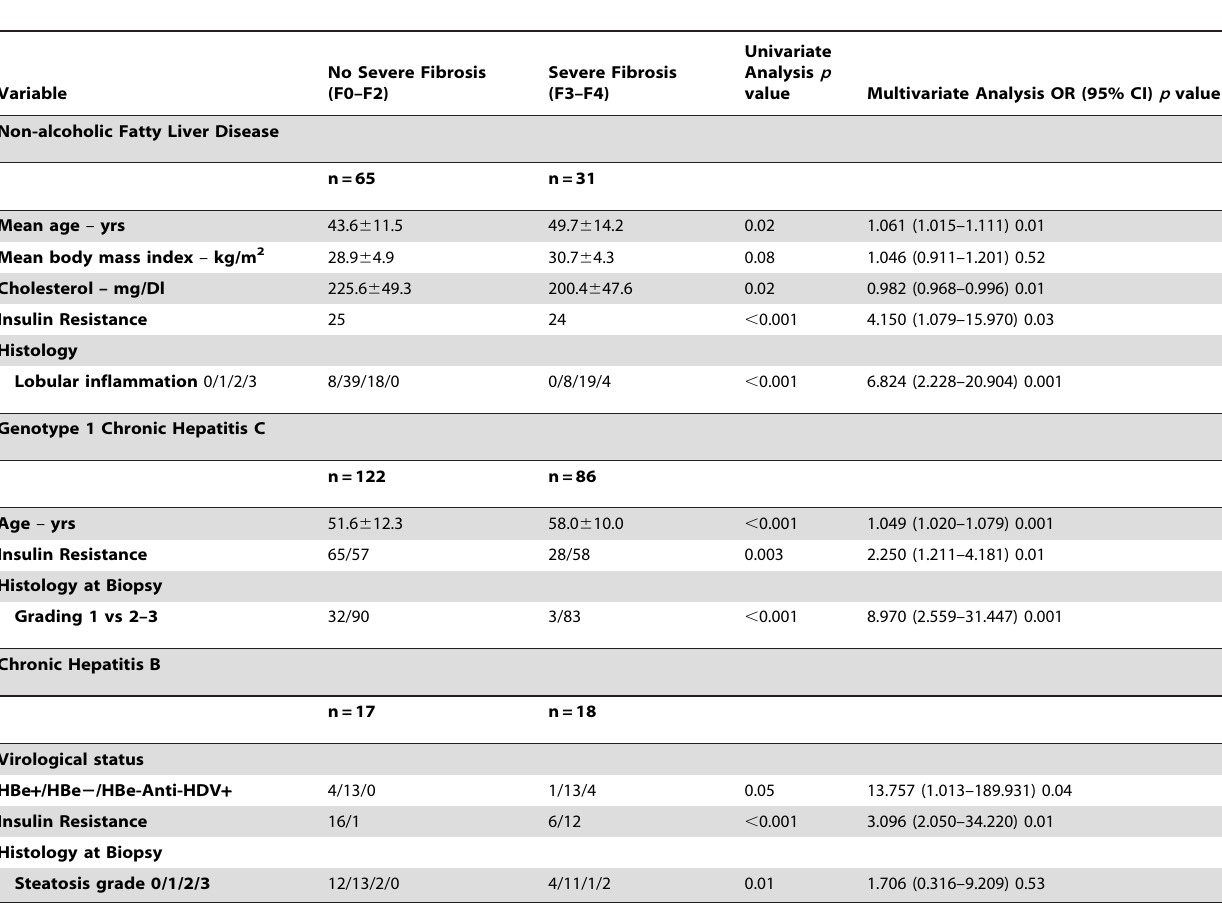
Table 5. Univariate and Multivariate Analysis of Risk Factors Associated with Severe Fibrosis (F3–F4) in 339 Patients with chronic liver disease (Chronic Hepatitis C, Non-alcoholic Fatty Liver Disease and Chronic Hepatitis B) and abnormal GGT values, by Logistic Regression